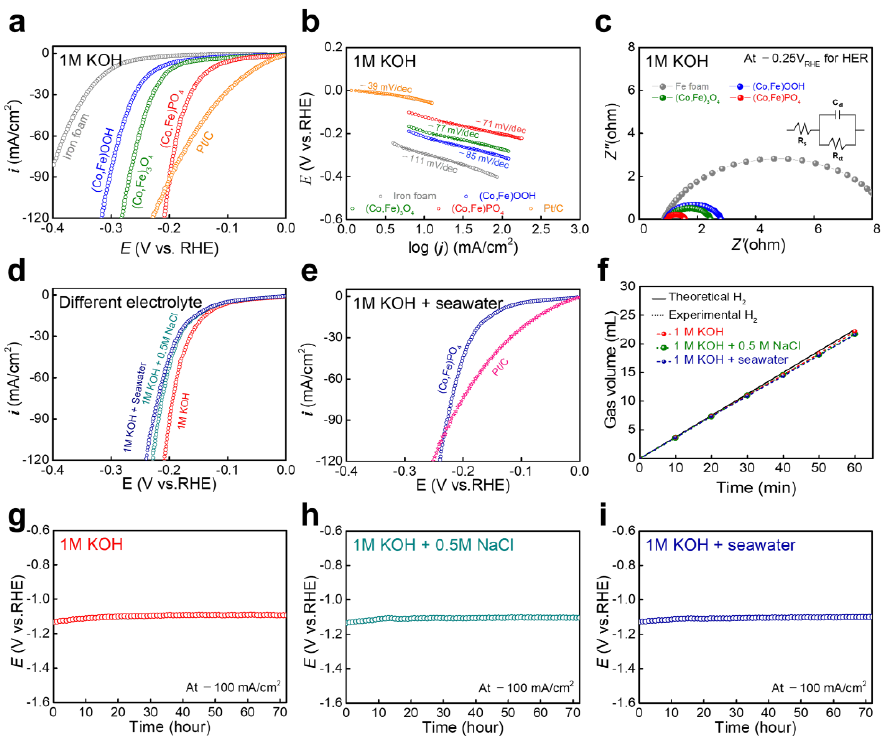
Figure 4. Electrochemical analyses for HER. ( a ) Forward scan polarization curves for HER in 1 M KOH. ( b ) Tafel plots for HER and ( c ) P-EIS at − 0.25 V RHE for HER. Polarization curves for HER in ( d ) different electrolytes and ( e ) 1 M KOH + seawater. ( f ) The FEs of (Co,Fe)PO 4 in 1 M KOH and 1 M KOH + seawater at 50 mA/cm 2 . Durability test at a constant current density of − 100 mA/cm 2 for 72 h in ( g ) 1.0 M KOH, ( h ) 1.0 M KOH + 0.5 M NaCl, and ( i ) 1.0 M KOH +